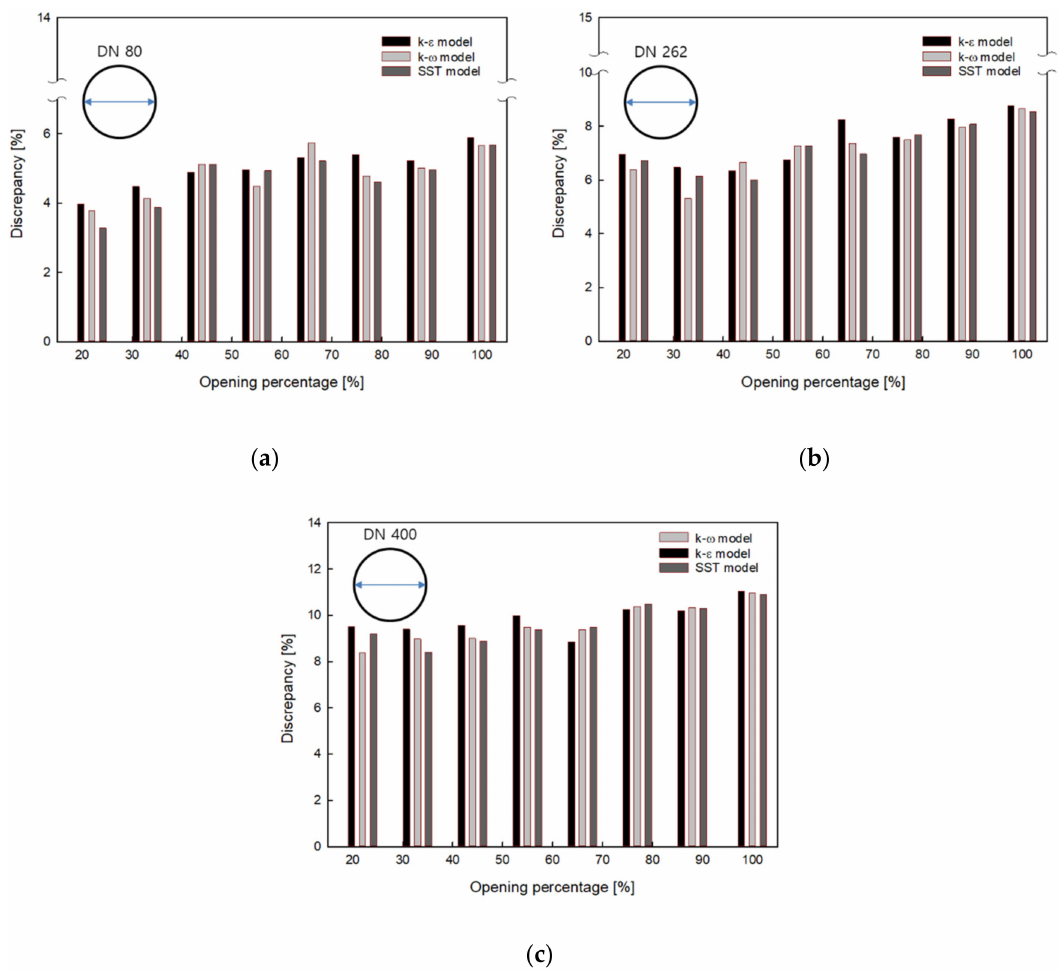
Figure 3. Discrepancies of flow coefficient results for the different turbulence models with different-sized valves and opening percentage: ( a ) DN 80 valves, ( b ) DN 262 valves, ( c ) DN 400